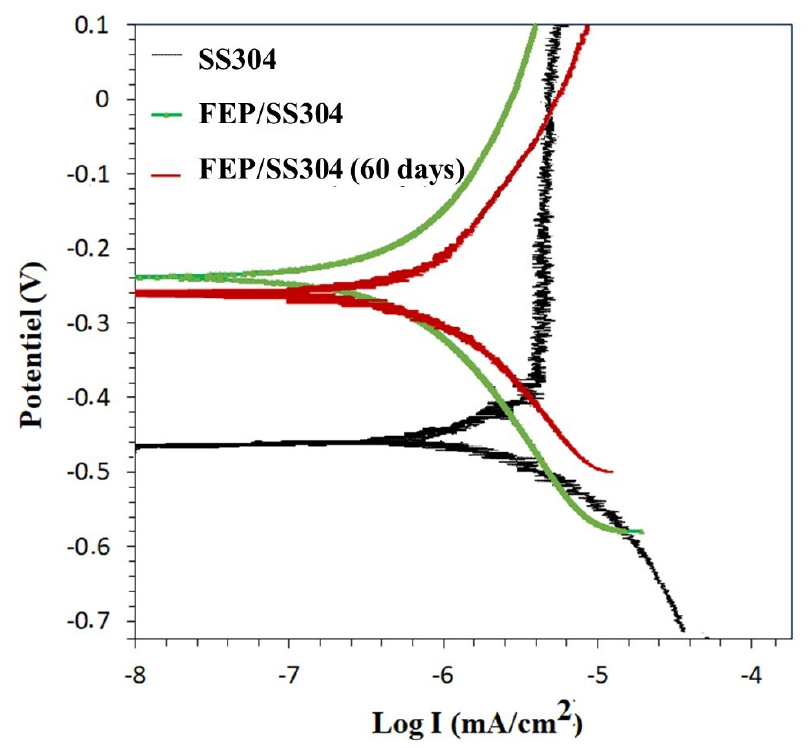
Figure 7. Polarization curve of SS304 and FEP coatings in 3.5% NaCl for 1 h and for 60 days. Table 3. Potentiodynamic polarization data of SS304 and FEP coating. Immersion Time